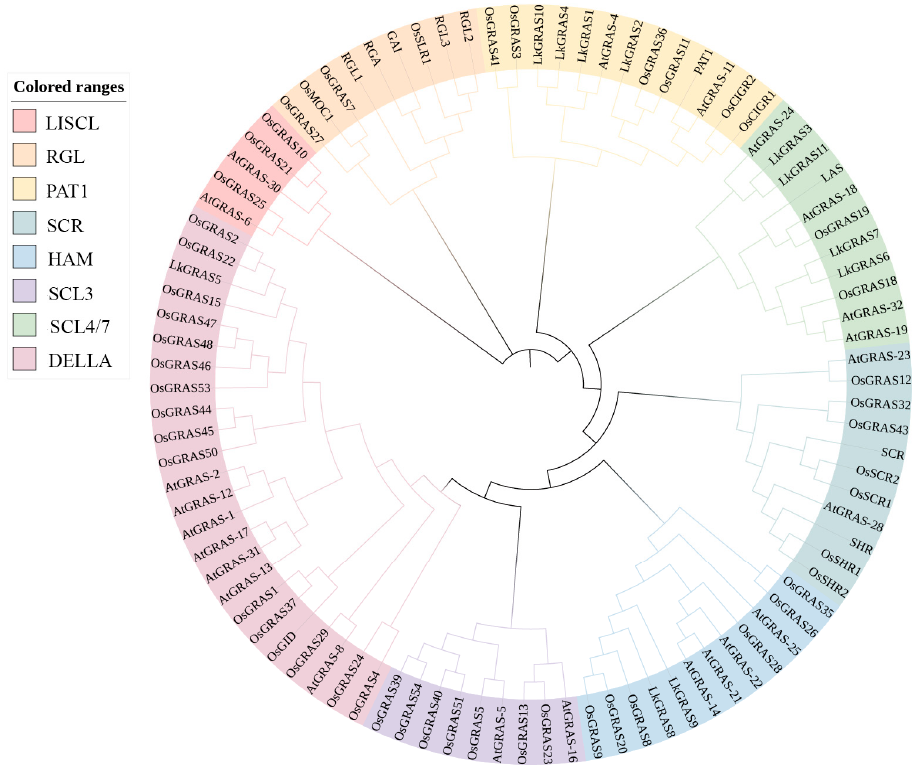
Figure 2. Phylogenetic analysis of the GRAS gene family members from L. kaempferi , O. sativa , and A. thaliana . Branches with less than 50% bootstrap support were collapsed. The phylogenetic tree was constructed using the maximum likelihood (ML) method of MEGA 7.0 with 500 bootstrap